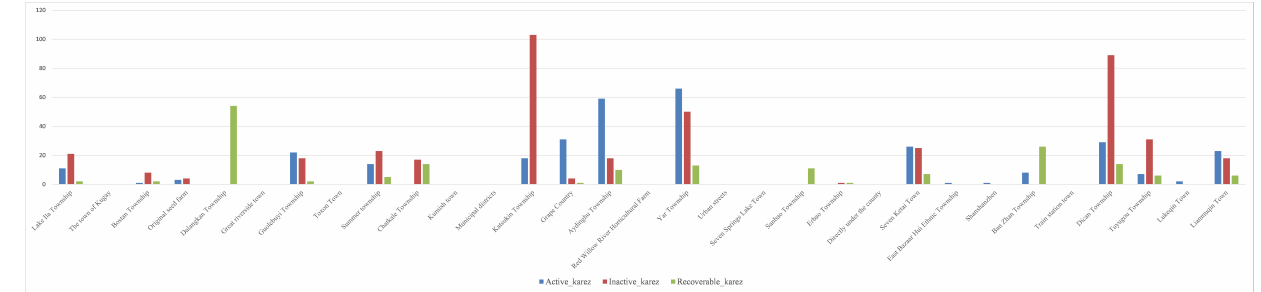
Figure 6. Comparison of the number of active karezes, inactive karezes, and recoverable karezes in the 31 townships of the Turpan Basin in 2004.